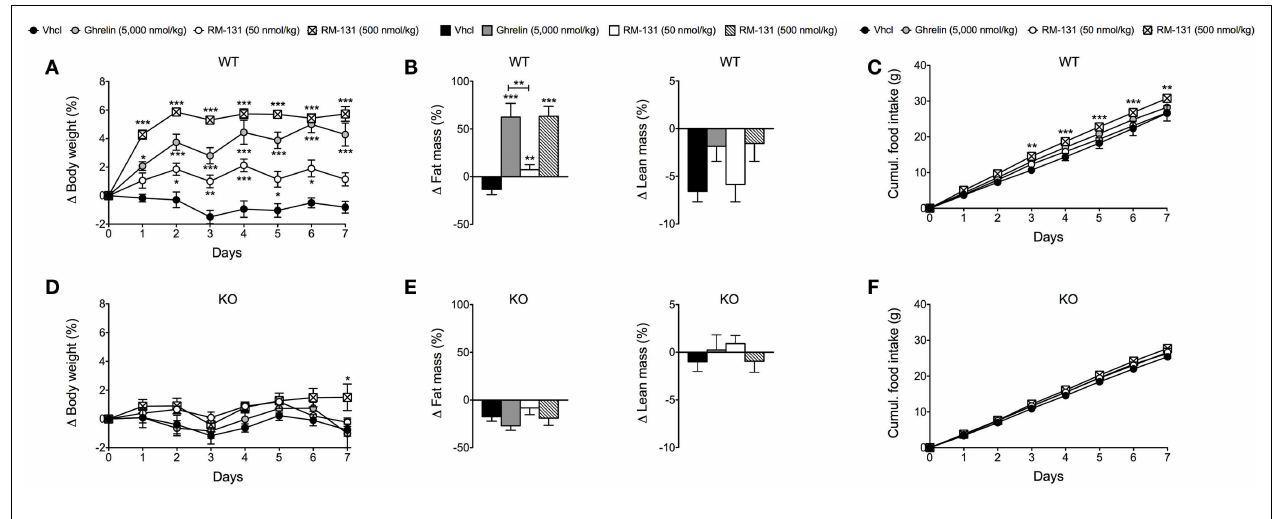
subcutaneous injections of ghrelin (5,000nmol/kg), RM-131 (50 or 500nmol/kg), or vehicle control. N = 8 each genotype and treatment group. Data represent means ± SEM. Asterisks indicate * p < 0.05; ** p < 0.01; *** p <